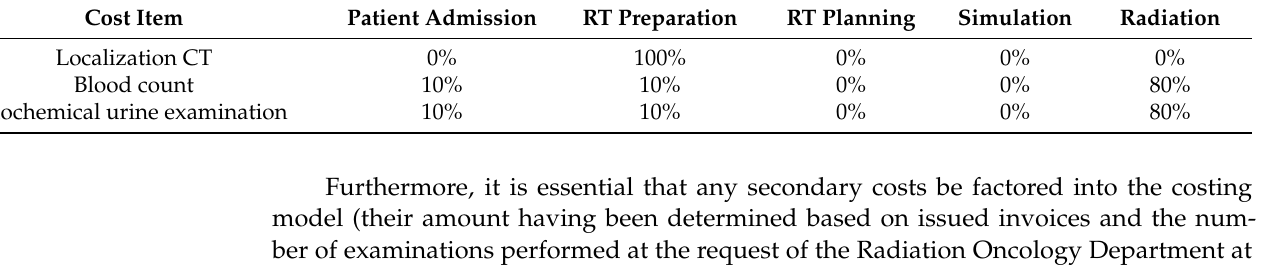
Table 7. The percentage distribution of secondary costs among component activities based on actual usage. Cost